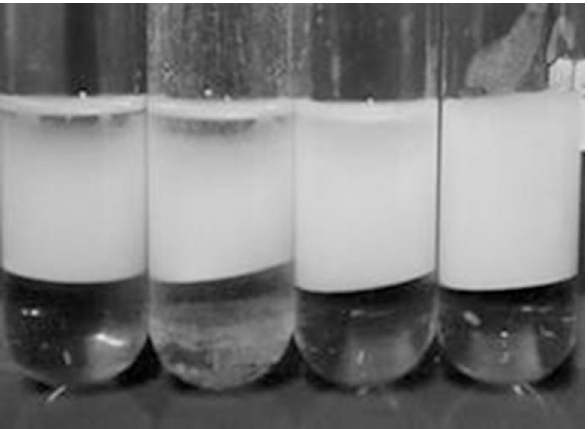
Fig 5. n-Hexadecane emulsion test. Last-day fermentation supernatant (free of glycerol) was diluted1000 times and vigorously vortexed with equal parts of n-hexadecane, and left to stand for 24 hours. Then, the capacityof emulsifyingthe alkanewas analyzed.From left to right: P . aeruginosa PAO1, with a C/N ratio of 17.5 and 83.2, then, P . aeruginosa -estA with a C/N ratio of 17.5 and 83.2 (mol/mol), respectively.